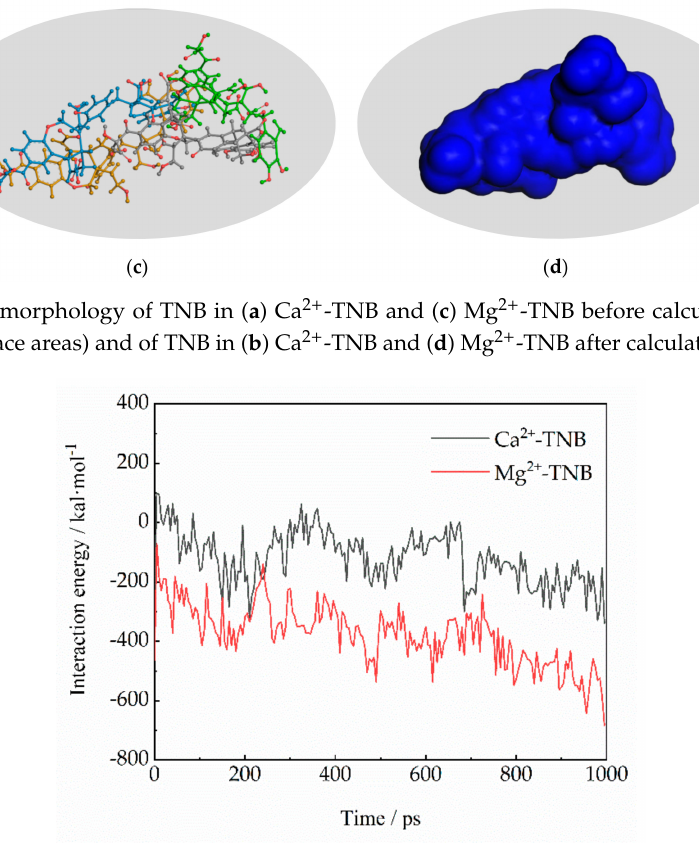
Figure 8. Interaction energy between metal ions and TNB.